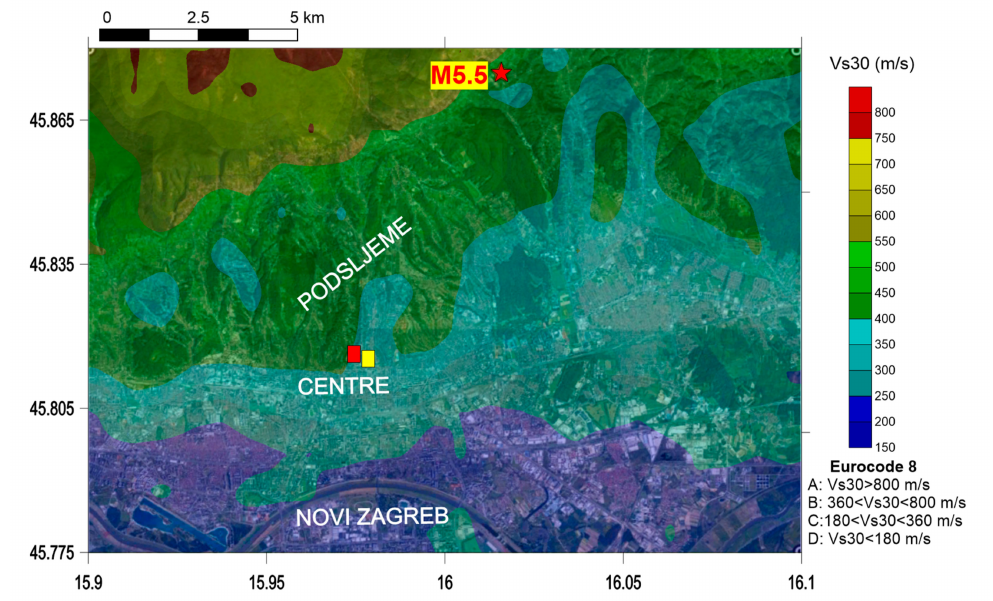
Figure 8. V S 30 map of the Zagreb area obtained based on approximation via correlation to topographic slope ([46]; source: [47]). Locations of Zagreb Cathedral (yellow square) and Croatian Parliament (red square) are shown. The M5.5 epicenter location is marked with a red